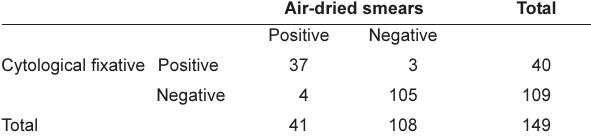
TABLE 4 Inter-rater comparison for diagnosis of bacterial